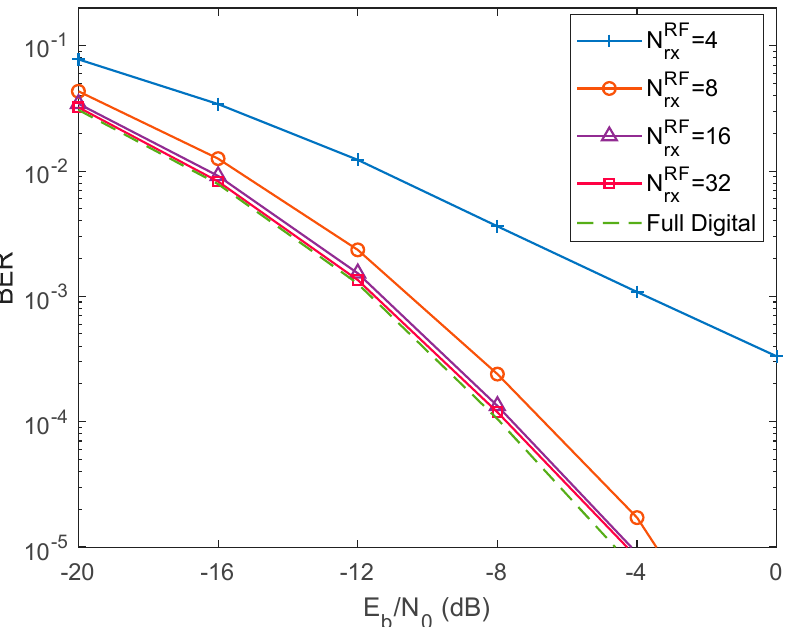
Figure 6. Performance comparison of the proposed hybrid AoD-based precoder with the full digital system for N tx = 16 and N rx =